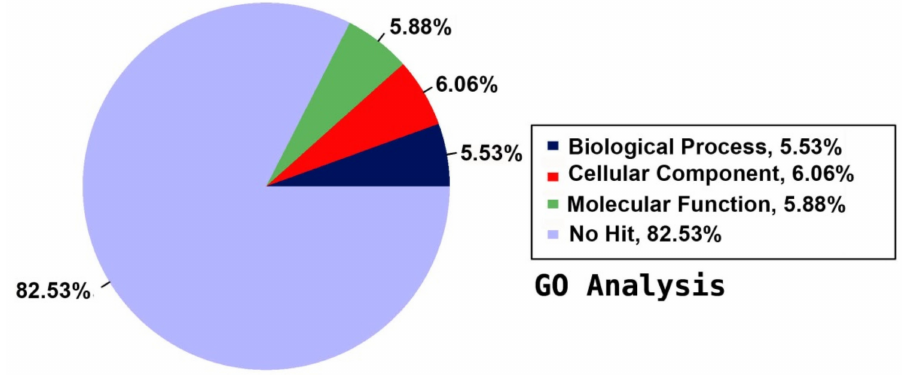
Figure 1. Summary of Gene Ontology (GO) annotation using the detected unigenes of the jojoba transcriptome of developing